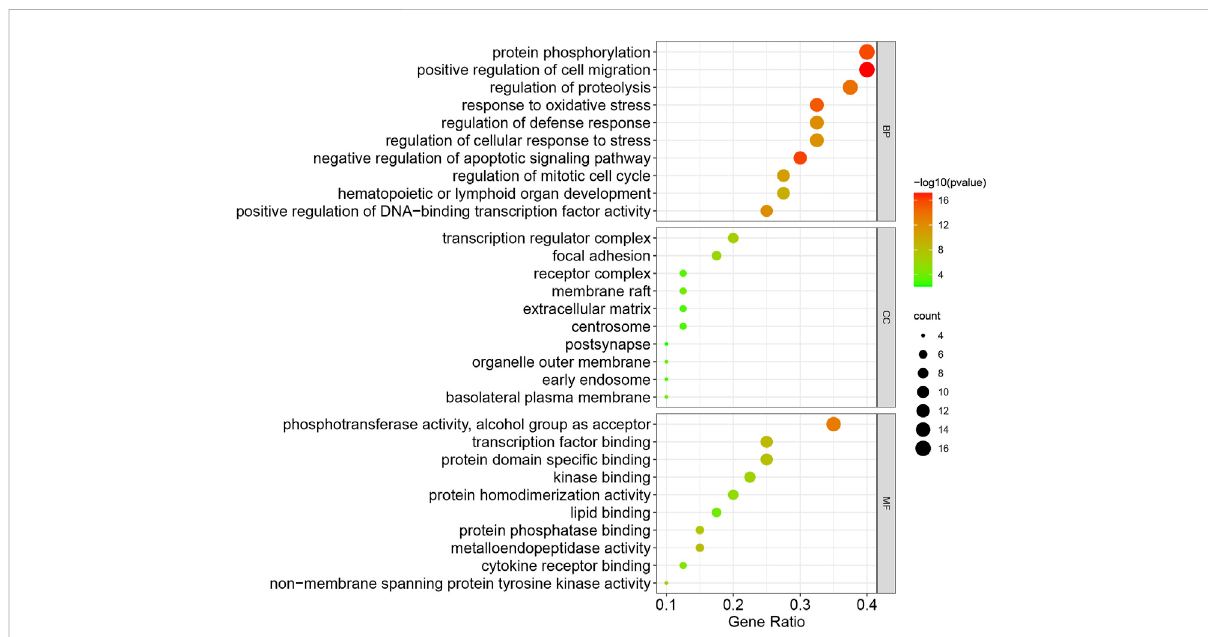
FIGURE 3 The top 10 of BP, CC, and MF in the GO enrichment analysis of the common targets of CUR and TNBC. (BP, biological process; CC, cellular component; MF, molecular